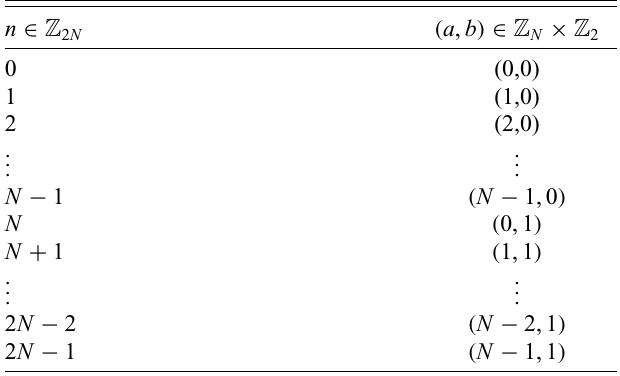
TABLE II. The elements of Z 2 N labeled by elements of Z N ×